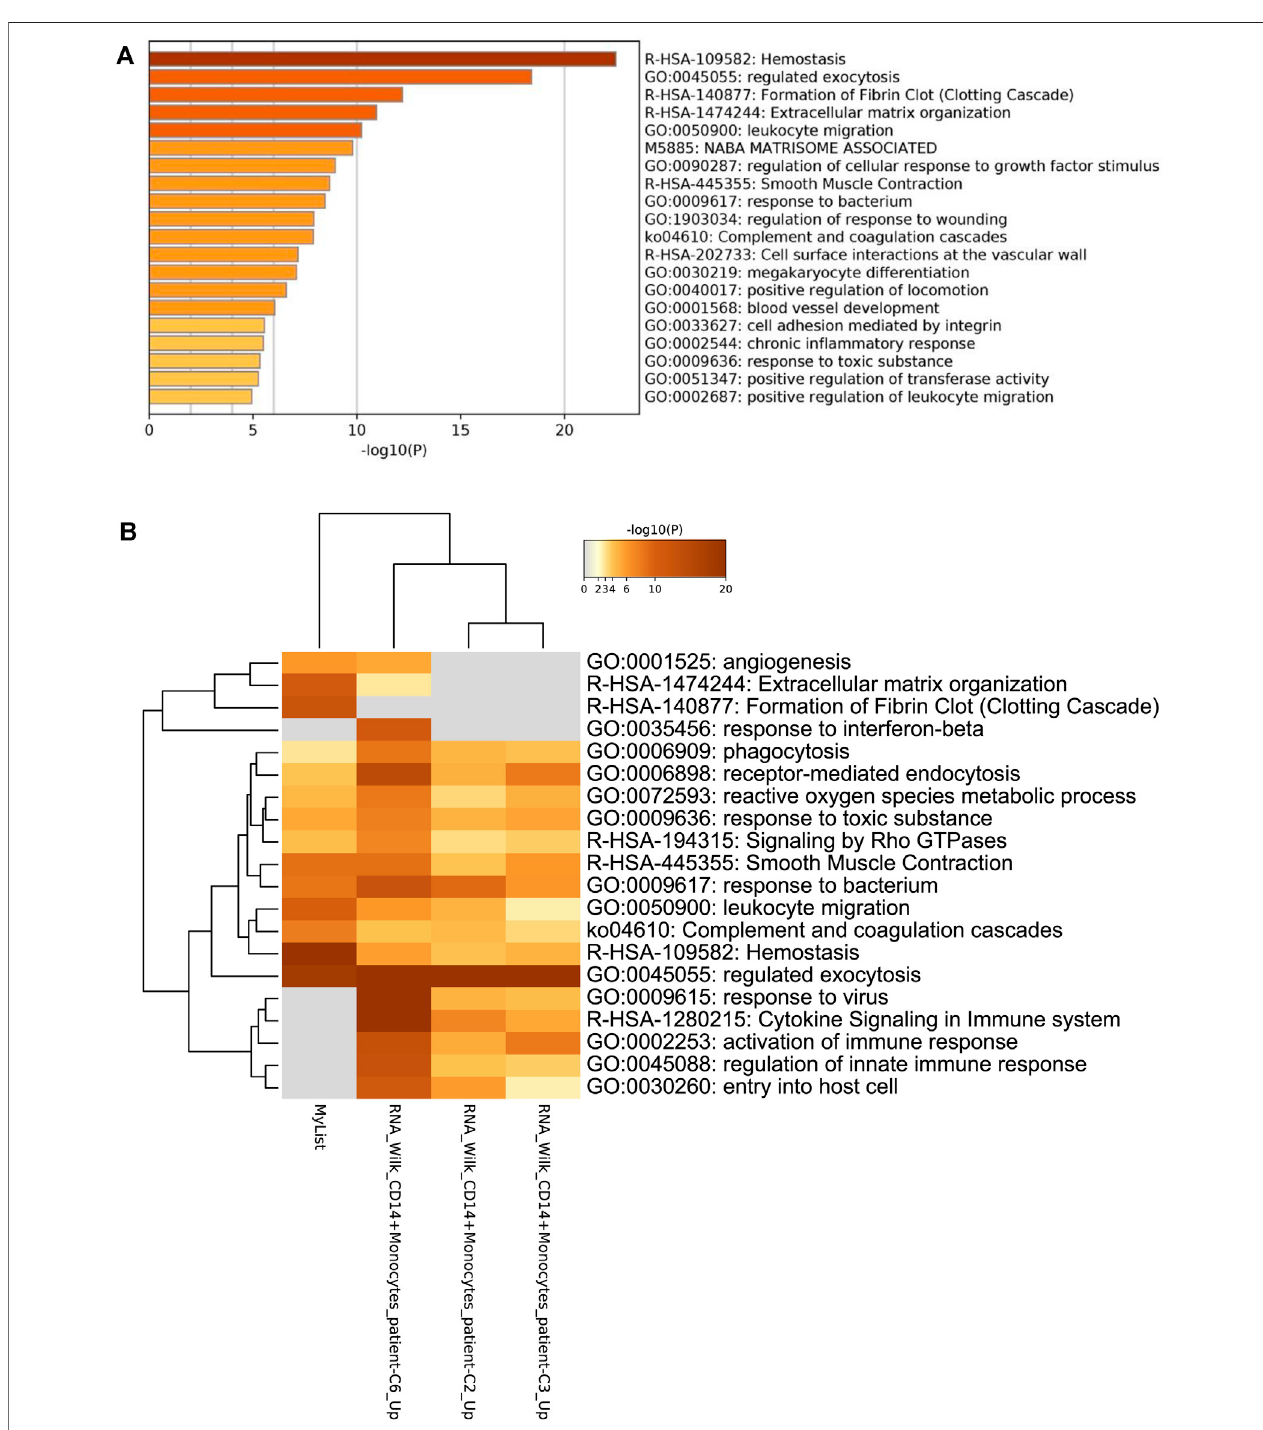
FIGURE14| Geneenrichmentanalysisof (A) regularpathwaysisshowingthatthemostcommonpathwayisthatofhemostasisandexocytosisandarealllinkedto cell differentiation. While in (B) COVID-19 gene lists, they are followed with angiogenesis, phagocytosis, and several immune responses.